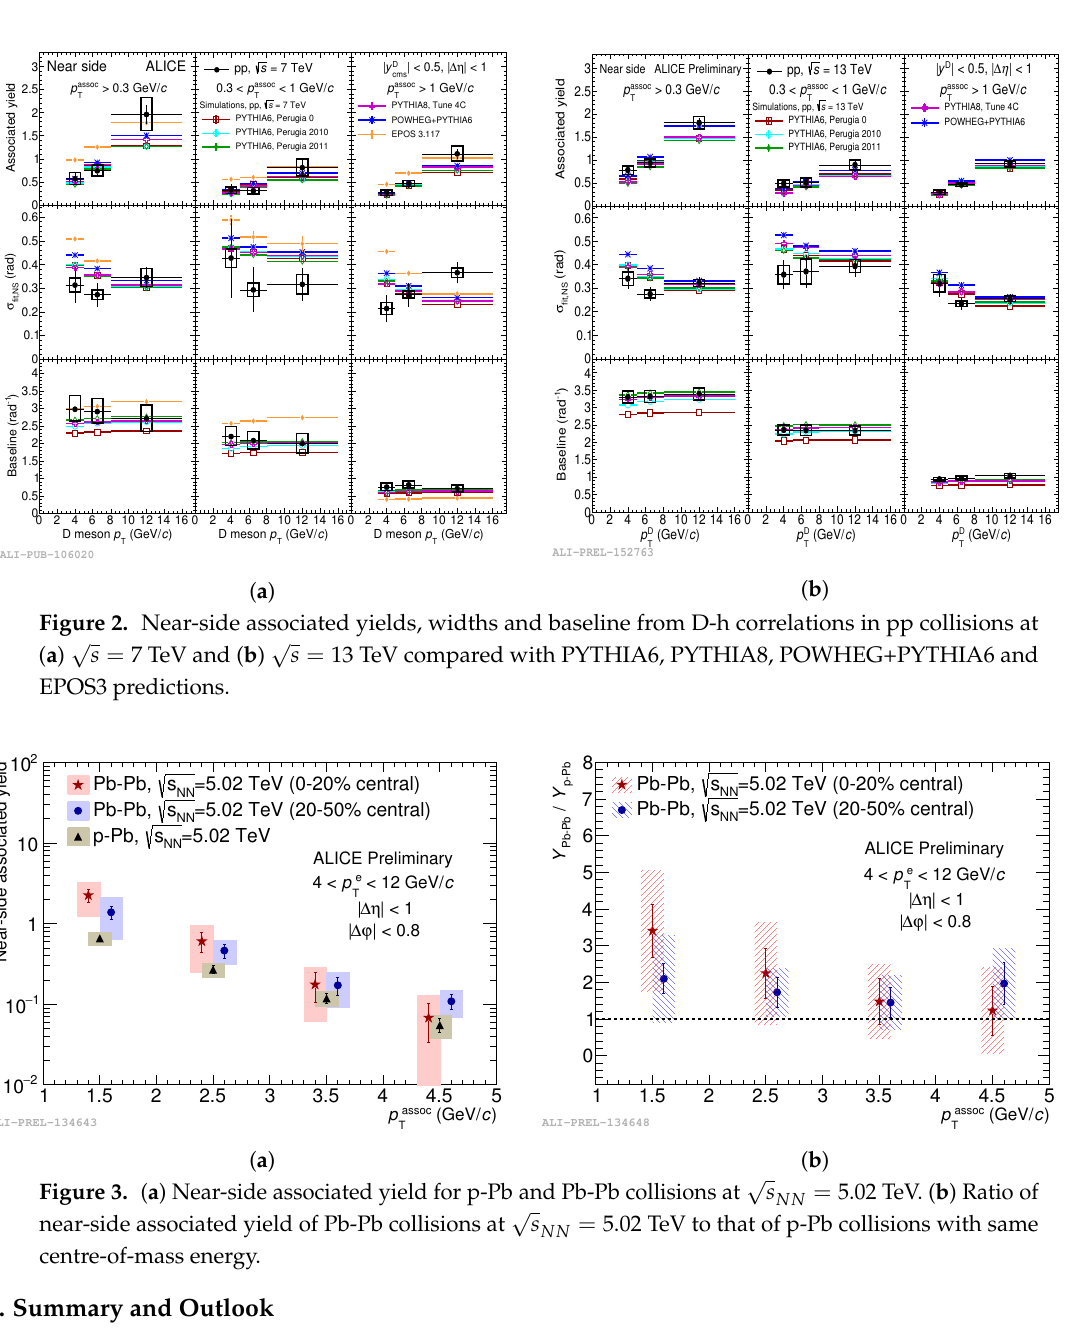
Figure 3. ( a ) Near-side associated yield for p-Pb and Pb-Pb collisions at near-side associated yield of Pb-Pb collisions at centre-of-mass